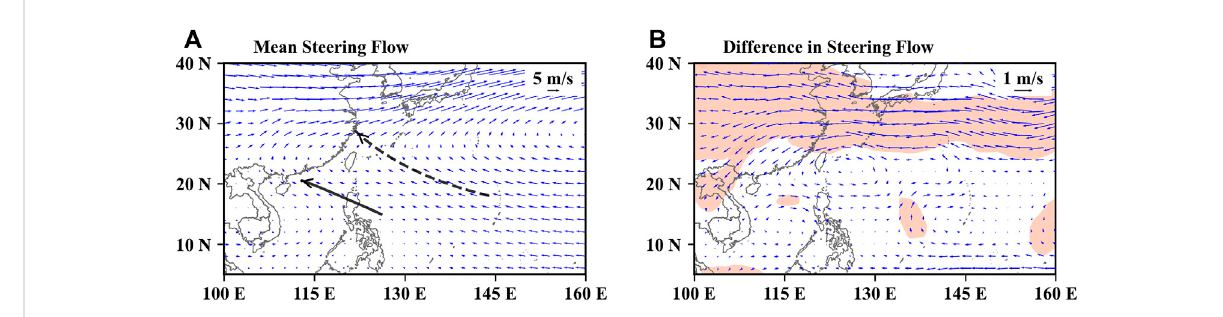
FIGURE 9 The same as Figure 6, but for the Steering Flow (m s − 1 ). The thick black solid (dashed) curves with arrows in (A) schematically denote the mean regression trajectories of TCs making landfall in SC (EC). The shaded area in pink (B) refers to the difference being signi fi cant at a con fi dence level of